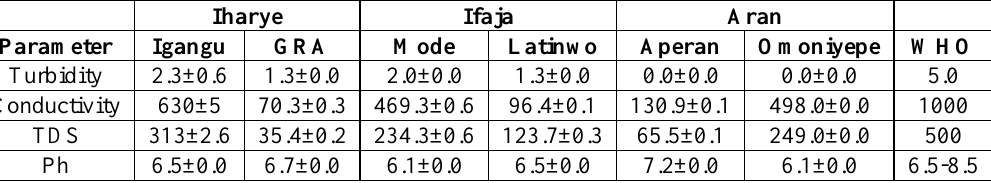
Table 2: Physical analysis of water samples.